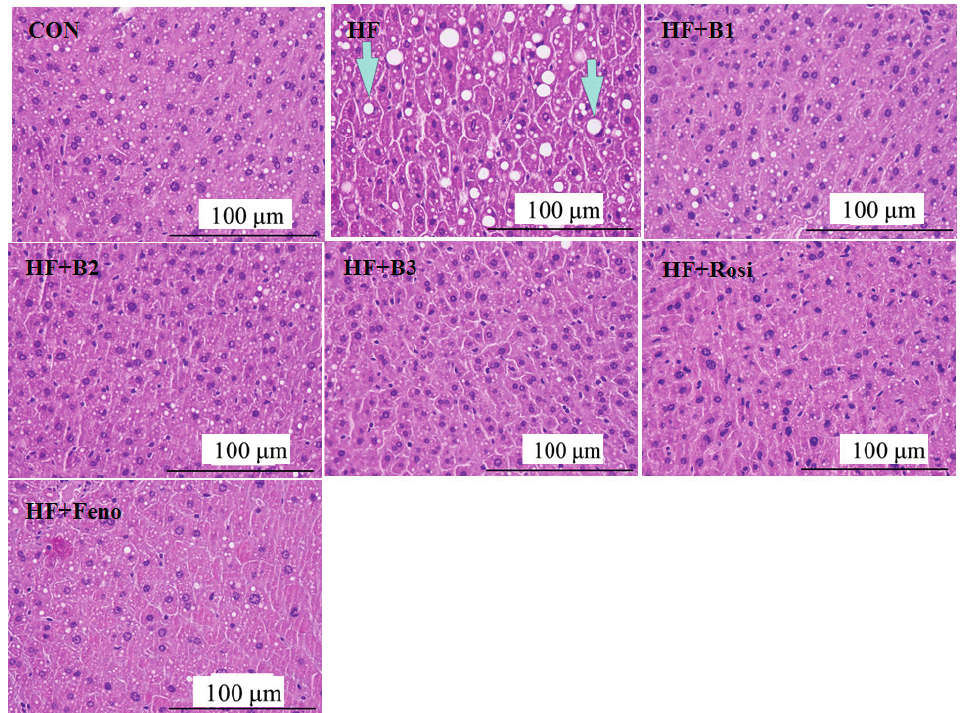
Figure 4. Pathological effects of ( − )-epicatechin-3- O - β - D -allopyranoside (BB) on liver tissue morphology in the low-fat (CON), high-fat (HF; high-fat diet control), HF + B1, HF + B2, HF + B3, or HF + Rosi, and HF + Feno groups. Pictures of hematoxylin